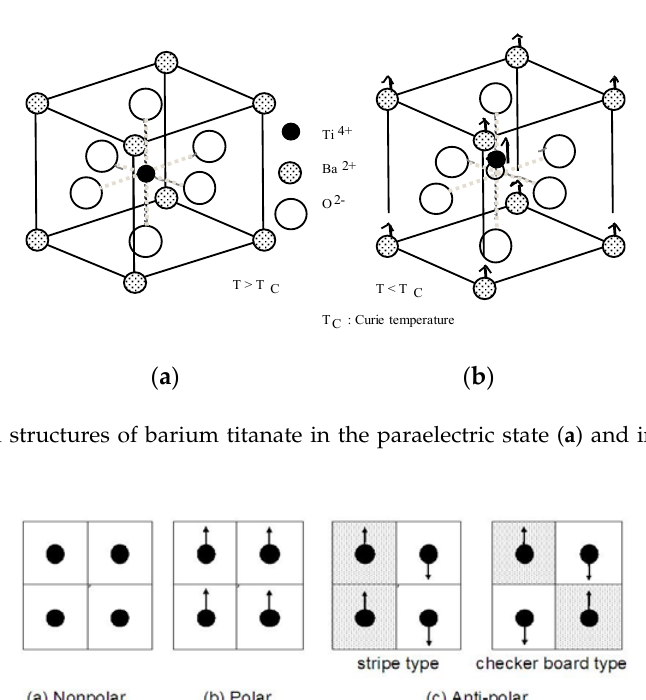
Figure 1. Comparison of the mechanisms for the shape memory effect in alloys ( a ) and in antiferroelectric ceramics ( b ).